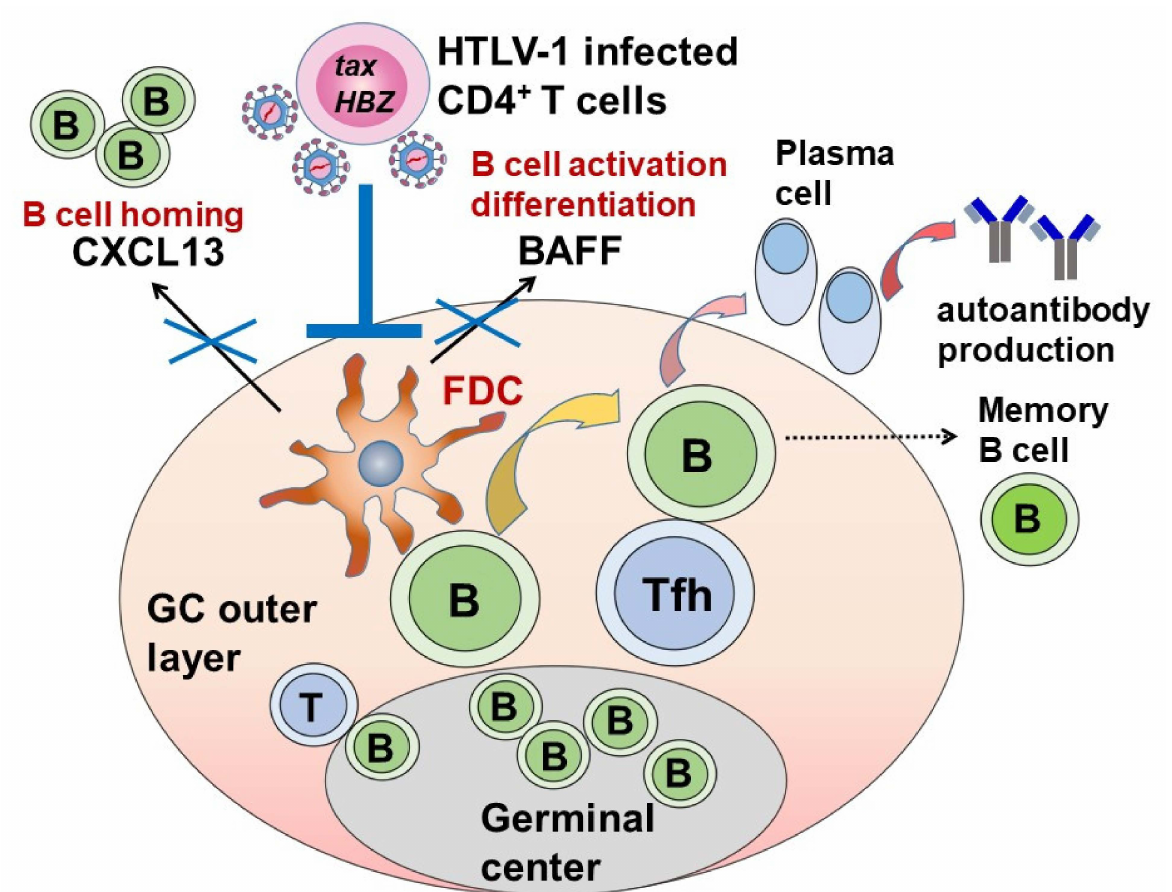
Figure 4. Hypothesis regarding the inhibitory effect of HTLV-1 against autoantibody production system in SS. B cells receive signals from follicular helper T cells (Tfh) after contact with follicular dendritic cells (FDCs) present in the germinal center outer layer. In cooperation with Tfh, memory B-cell production or plasma cell maturation and autoantibody production such as anti-Ro/SS-A antibody occur. Among the autoantibody production pathways, FDC plays a central role in B- cell homing by CXCL13 and B-cell activation and differentiation by BAFF (B-cell activating factor belonging to the tumor necrosis factor family). HTLV-1-infected cells may act directly on FDCs and reduce FDC function by suppressing the production of CXCL13 and